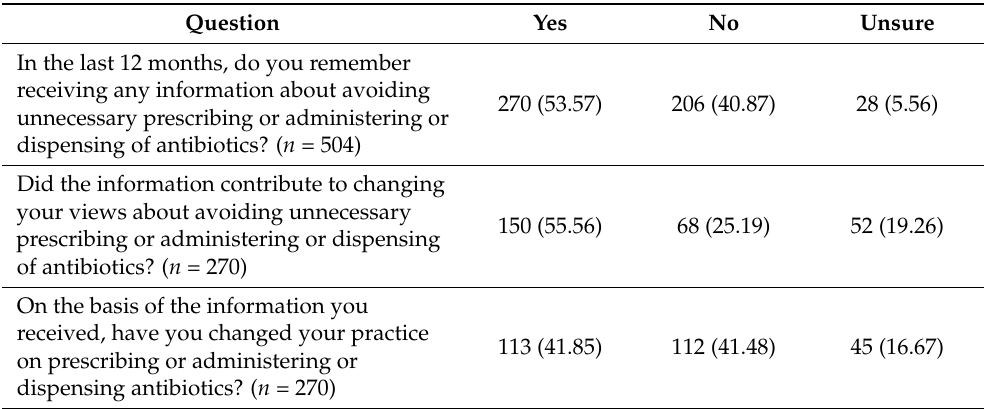
Table 2. Respondents who received information on avoiding unnecessary prescribing, administering or dispensing of antibiotics, and those reporting that the information contributed to changing their views or